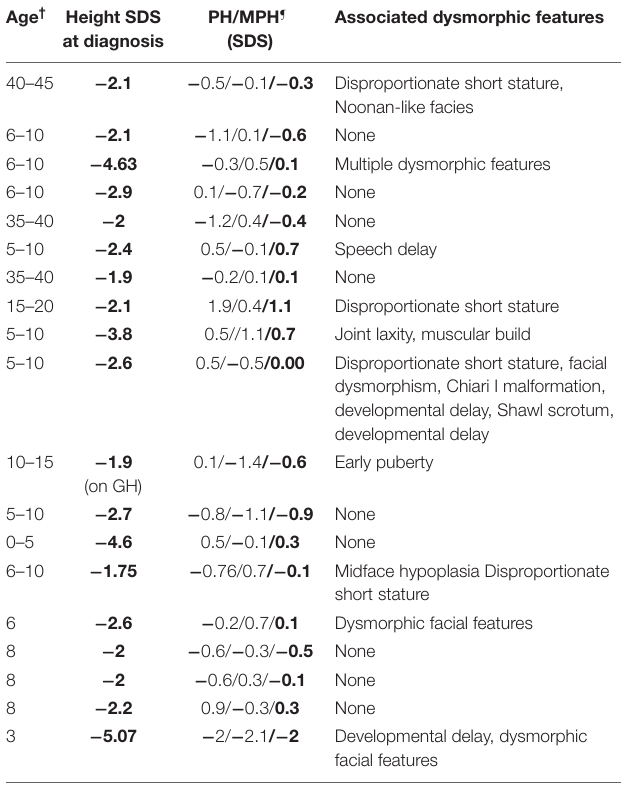
TABLE 2 | Characteristics of subjects with non-familial short